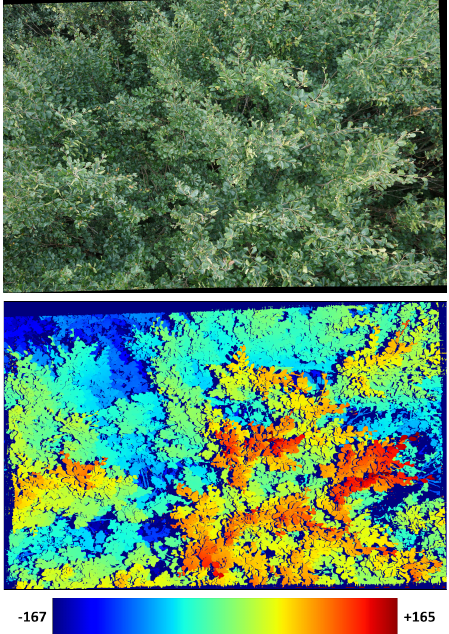
Figure 3. The master epipolar image and the disparity map